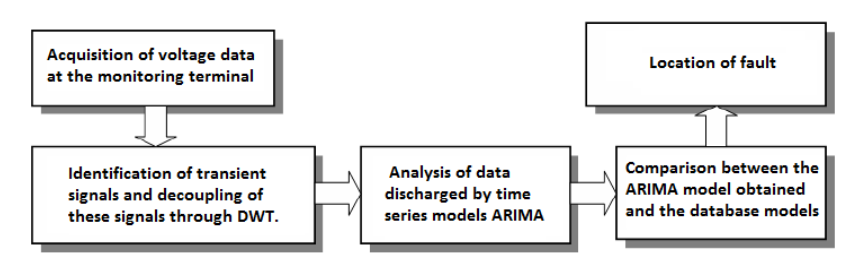
Figure 3. Schematic diagram for fault location with the proposed model. ARIMA : autoregressive integrated moving average; DWT : discrete wavelet transform.